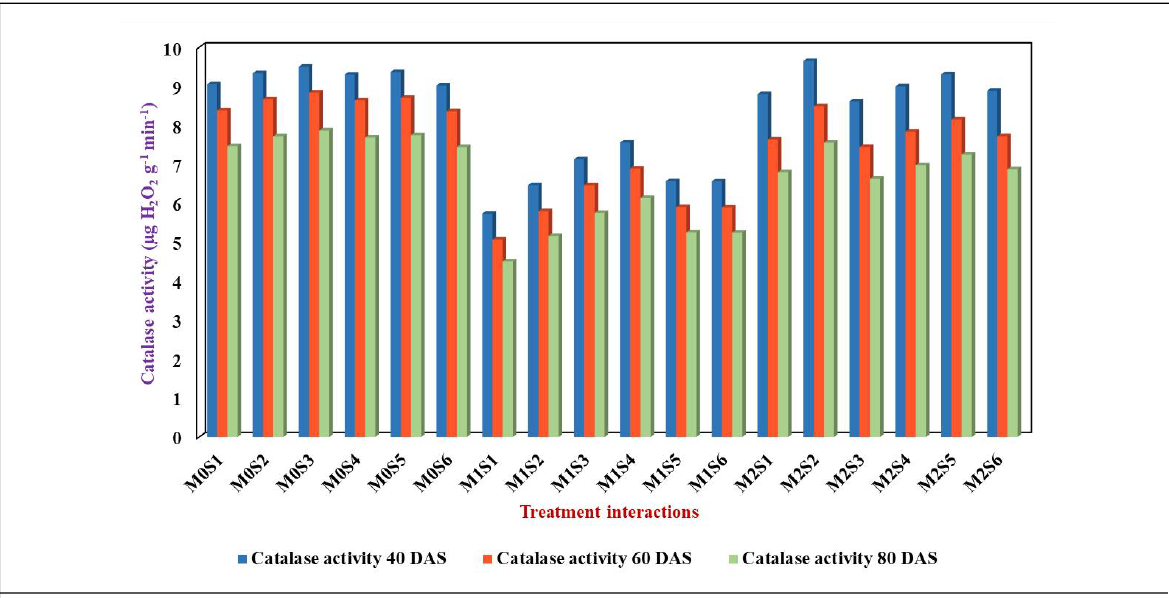
Figure 3: Effect of plant growth regulating chemicals on catalase activity (µg H2O2 g-1 min-1) of Bhendi Hybrid CO under moisture 4